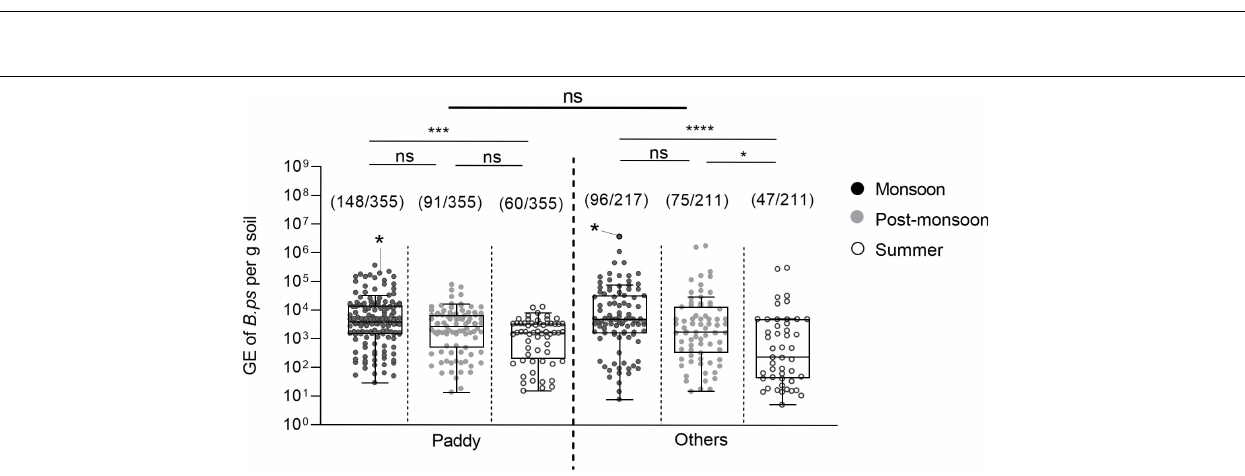
FIGURE 6 | Positivity rate of B. pseudomallei soil samples of paddy and other locations. (A) Positivity of soil samples based on direct qPCR in paddy and other fields depicted for all 1,704 samples and separated for Udupi and Shimoga. (B) B. pseudomallei positivity rate of soil samples from paddy fields (left) and other locations of Udupi (right). Dots in the bars represent the percentage of positive samples for single sites (Fisher’s exact test: * p < 0.05, ** p < 0.01).